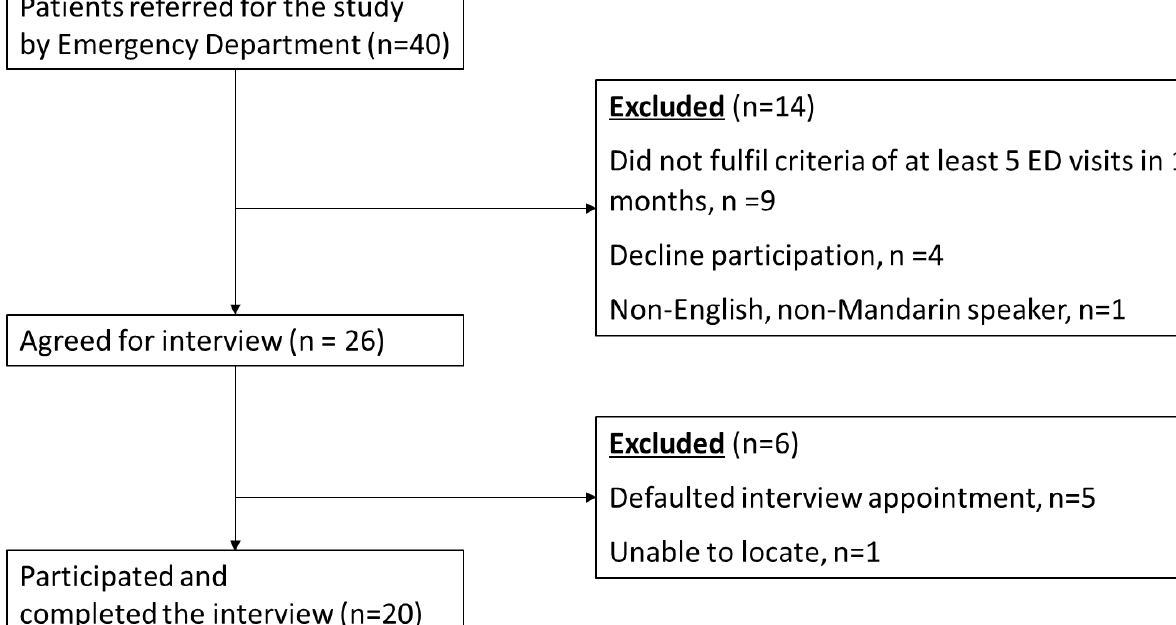
Figure 1. Flowchart of study enrolment.